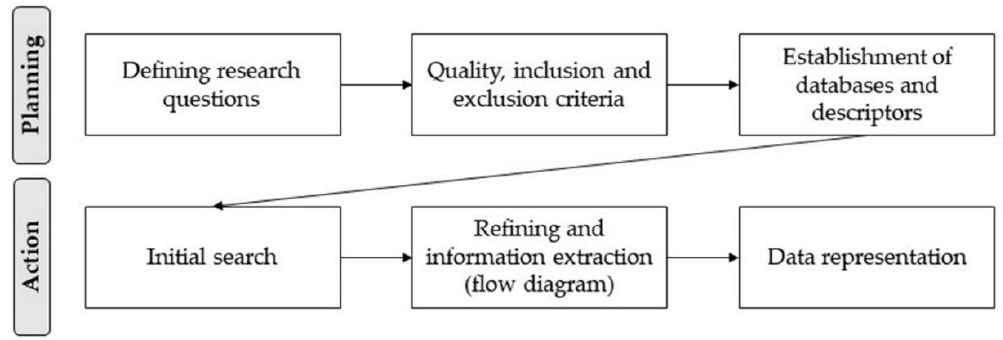
Figure 1. The systematic literature review process.